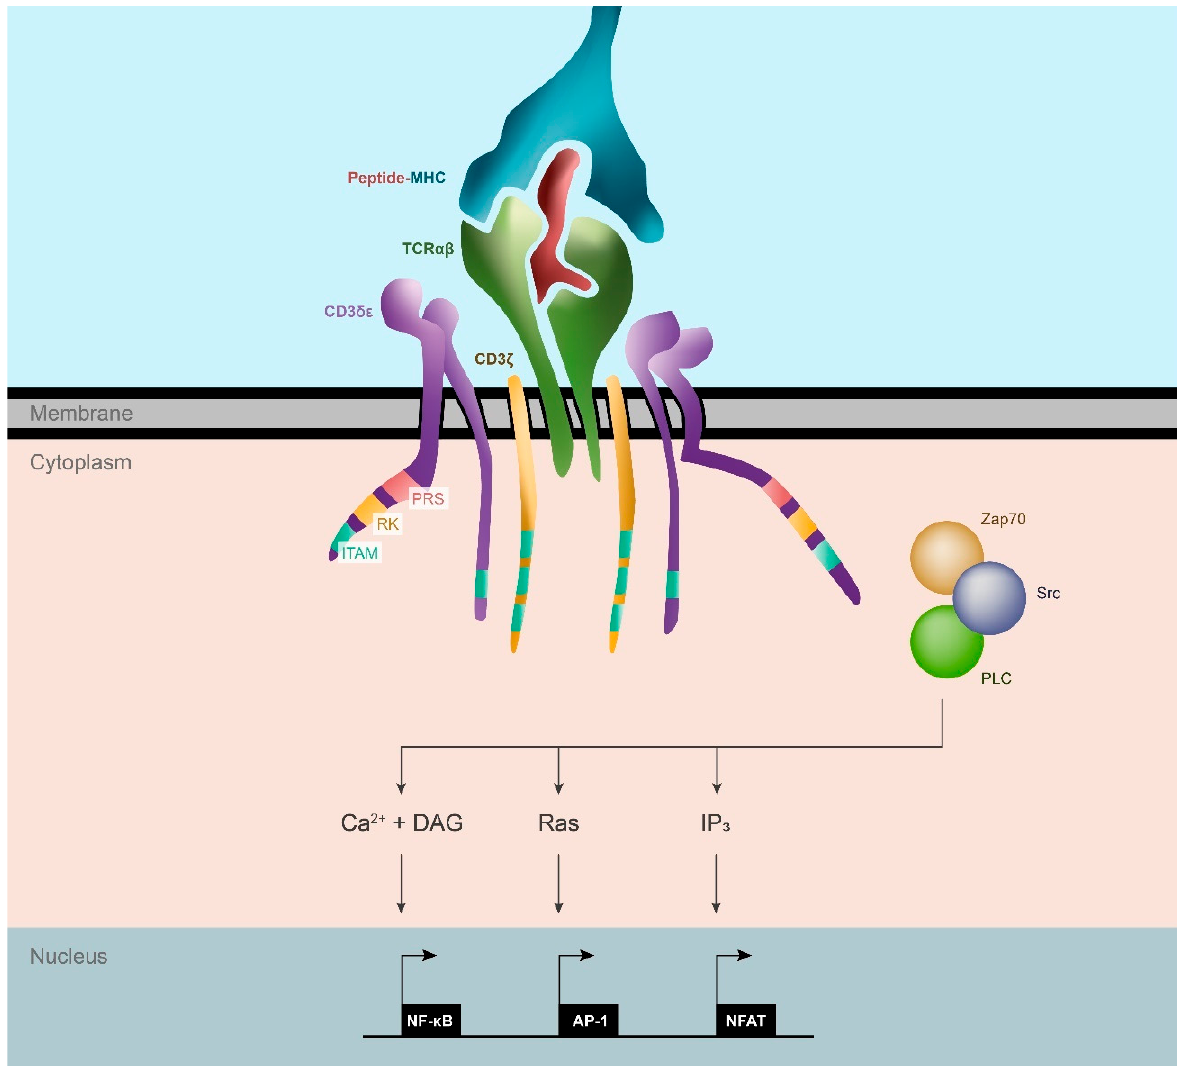
Figure 1. TCR structure and T cell activation pathway. The TCR αβ recognizes the pMHC complex on the antigen-presenting cell at the immunological synapse. The transduction of the signal is mediated by the ITAM domains located in the CD3 intracellular domains, which are phosphorylated by Src family kinases. The signaling axis comprises numerous factors, such as Zap70 and PLC. The cascade ends up with the production of second messengers (Ca 2+ , diacylglycerol (DAG), and IP 3 ) and the activation of Ras. These mediators lead to the upregulation of gene transcription by NF- κ B, AP-1, and NFAT, triggering the activation of the T cell.